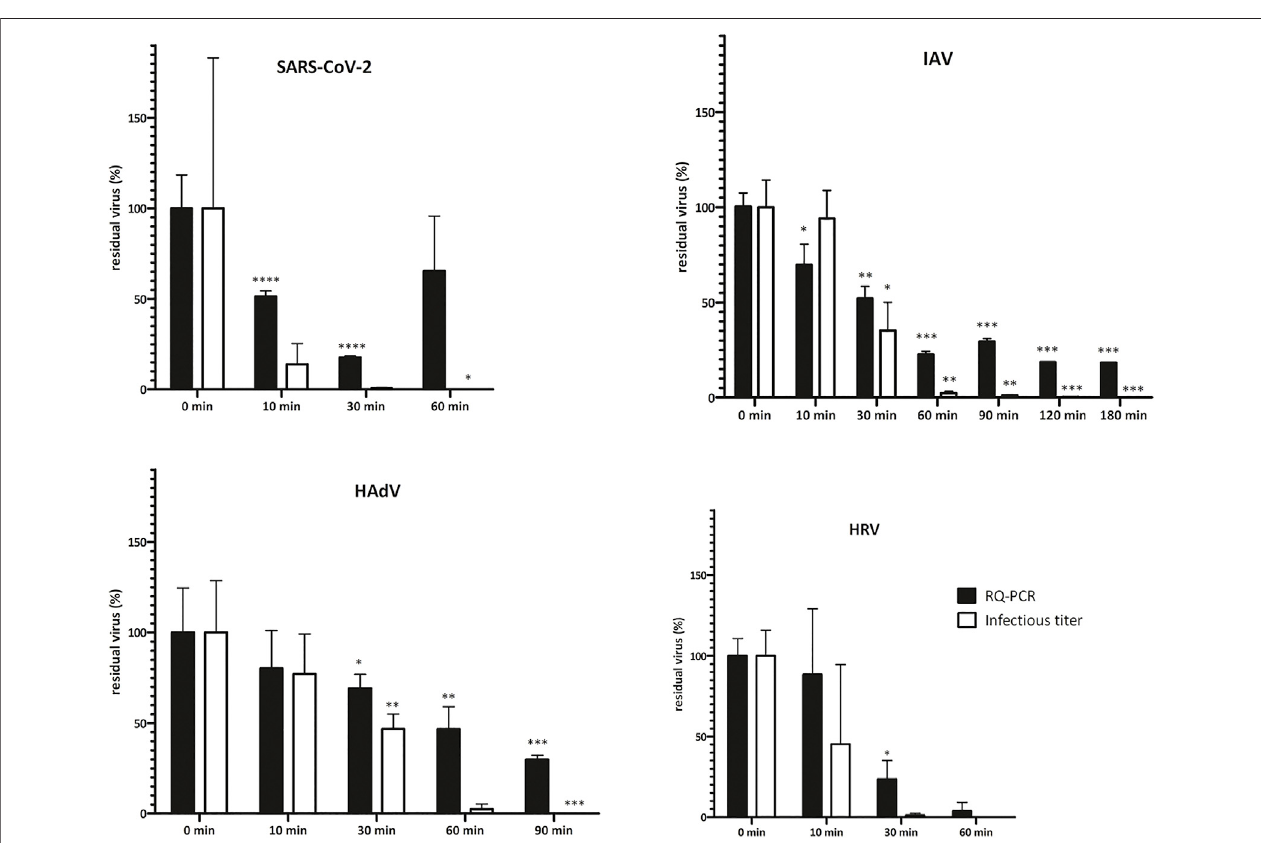
FIGURE 1 | Virus infectivity upon NTP treatment is reduced more rapidly than genome copy numbers. Virus inoculum (20 μ L, 10 6 IU/ml) was applied onto P3 R fi lters, dried and exposed to NTP for the indicated times. Residual virus was recovered by PBS-mediated elution and titers were determined by TCID50 or IF assay (infectioustiter)andqPCR(DNA/RNAgenomecopies).Dataareplottedas%ofuntreatedcontrolsamples(virusappliedonto fi ltersandkeptinalaminar fl owboxforthe respective times indicated on the abscissa); the mean of three biological replicates ±SEM is shown; t -test statistical analysis: * = p < 0.05, ** = p < 0.005, *** = p < 0.0005.AbsolutevaluesofvirustiteraredepictedinSupplementaryTableS1.Virusinfectivity(infectioustiter)decreasedwithNTPexposuretimeanddroppedbelow the detection limit of the assays employed after 60 – 180 min. The decrease in genome copy numbers (qPCR) re fl ecting physical integrity of the particles followed the same trend, albeit at a slower pace, indicating that infectivity was abolished before complete particle destruction was achieved. Fluctuations in test results re fl ect the complexity of the biological system. HAdV = human adenovirus, HRV = human Rhinovirus, IAV = In fl uenza A, SARS-CoV-2 = severe acute respiratory syndrome coronavirus 2, SEM = standard error of the